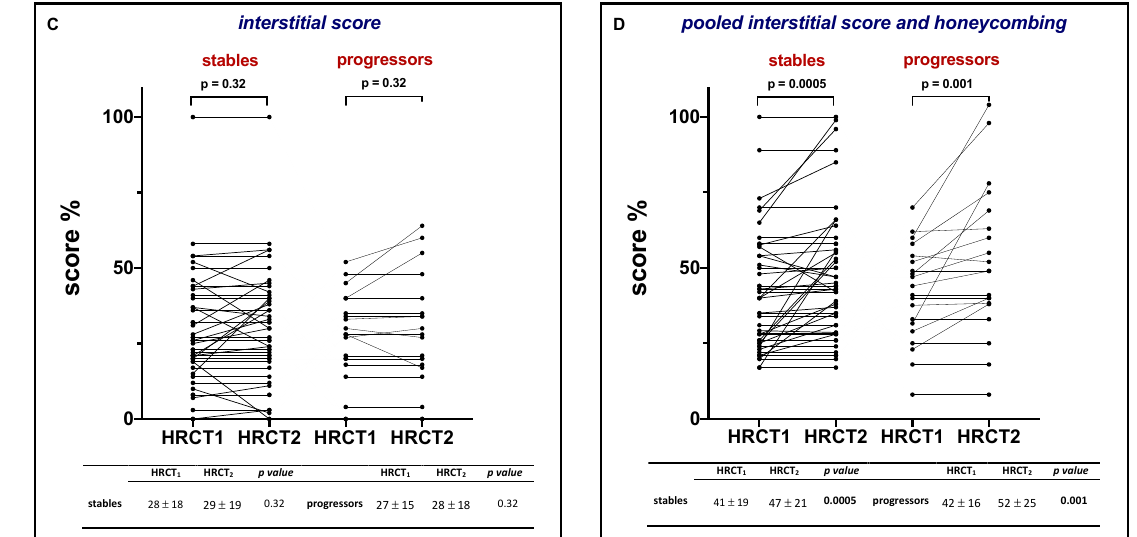
Figure 3. Change in alveolar score, honeycombing, interstitial score and pooled interstitial score and honeycombing between HRCT1 (at treatment initiation) and HRCT2 (after one year of treatment) in stable patients ( n = 48) and progressors ( n = 20). Values in the table below are expressed as mean and standard deviations. P values refer to comparisons between HRCT1 and HRCT2.